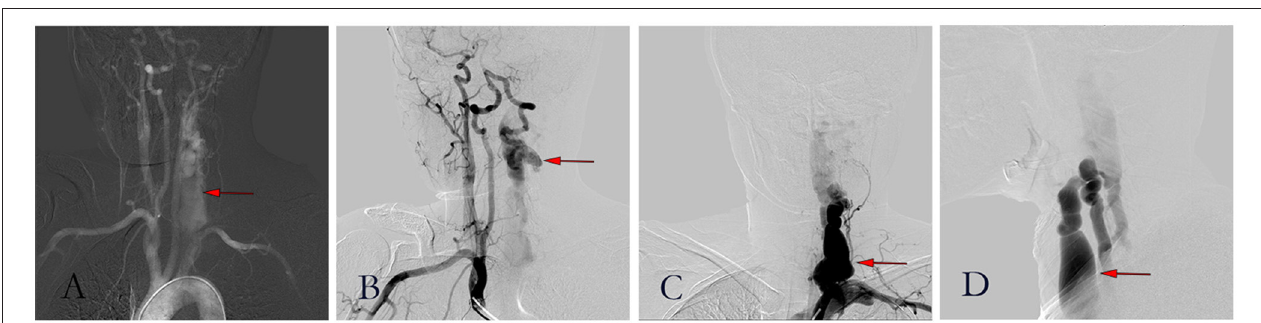
FIGURE 3 | Figures of preoperative three-dimensional computerized tomography. (A) The anterior view of the three-dimensional CT of vertebral arteriography; (B) The left view of the three-dimensional CT of vertebral arteriography; (C) The post view of the three-dimensional CT of vertebral arteriography; (D) Three-dimensional reconstruction of the left neck.